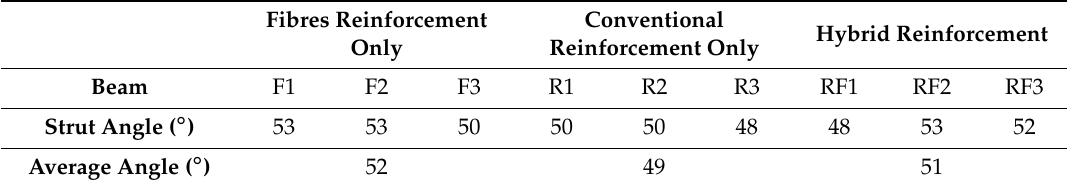
Table 4. θ v of each beam tested under torsional